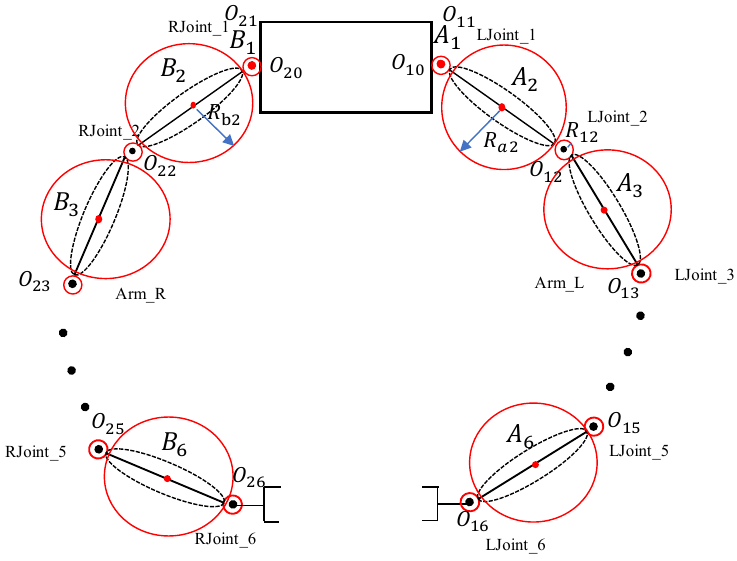
Figure 4. Bounding sphere model of the dual-arm robot.